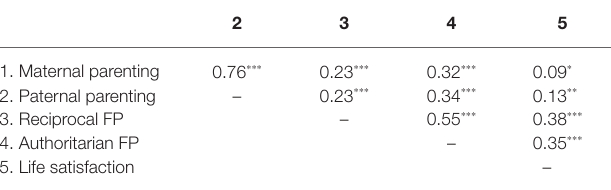
TABLE 1 | Correlation analysis between